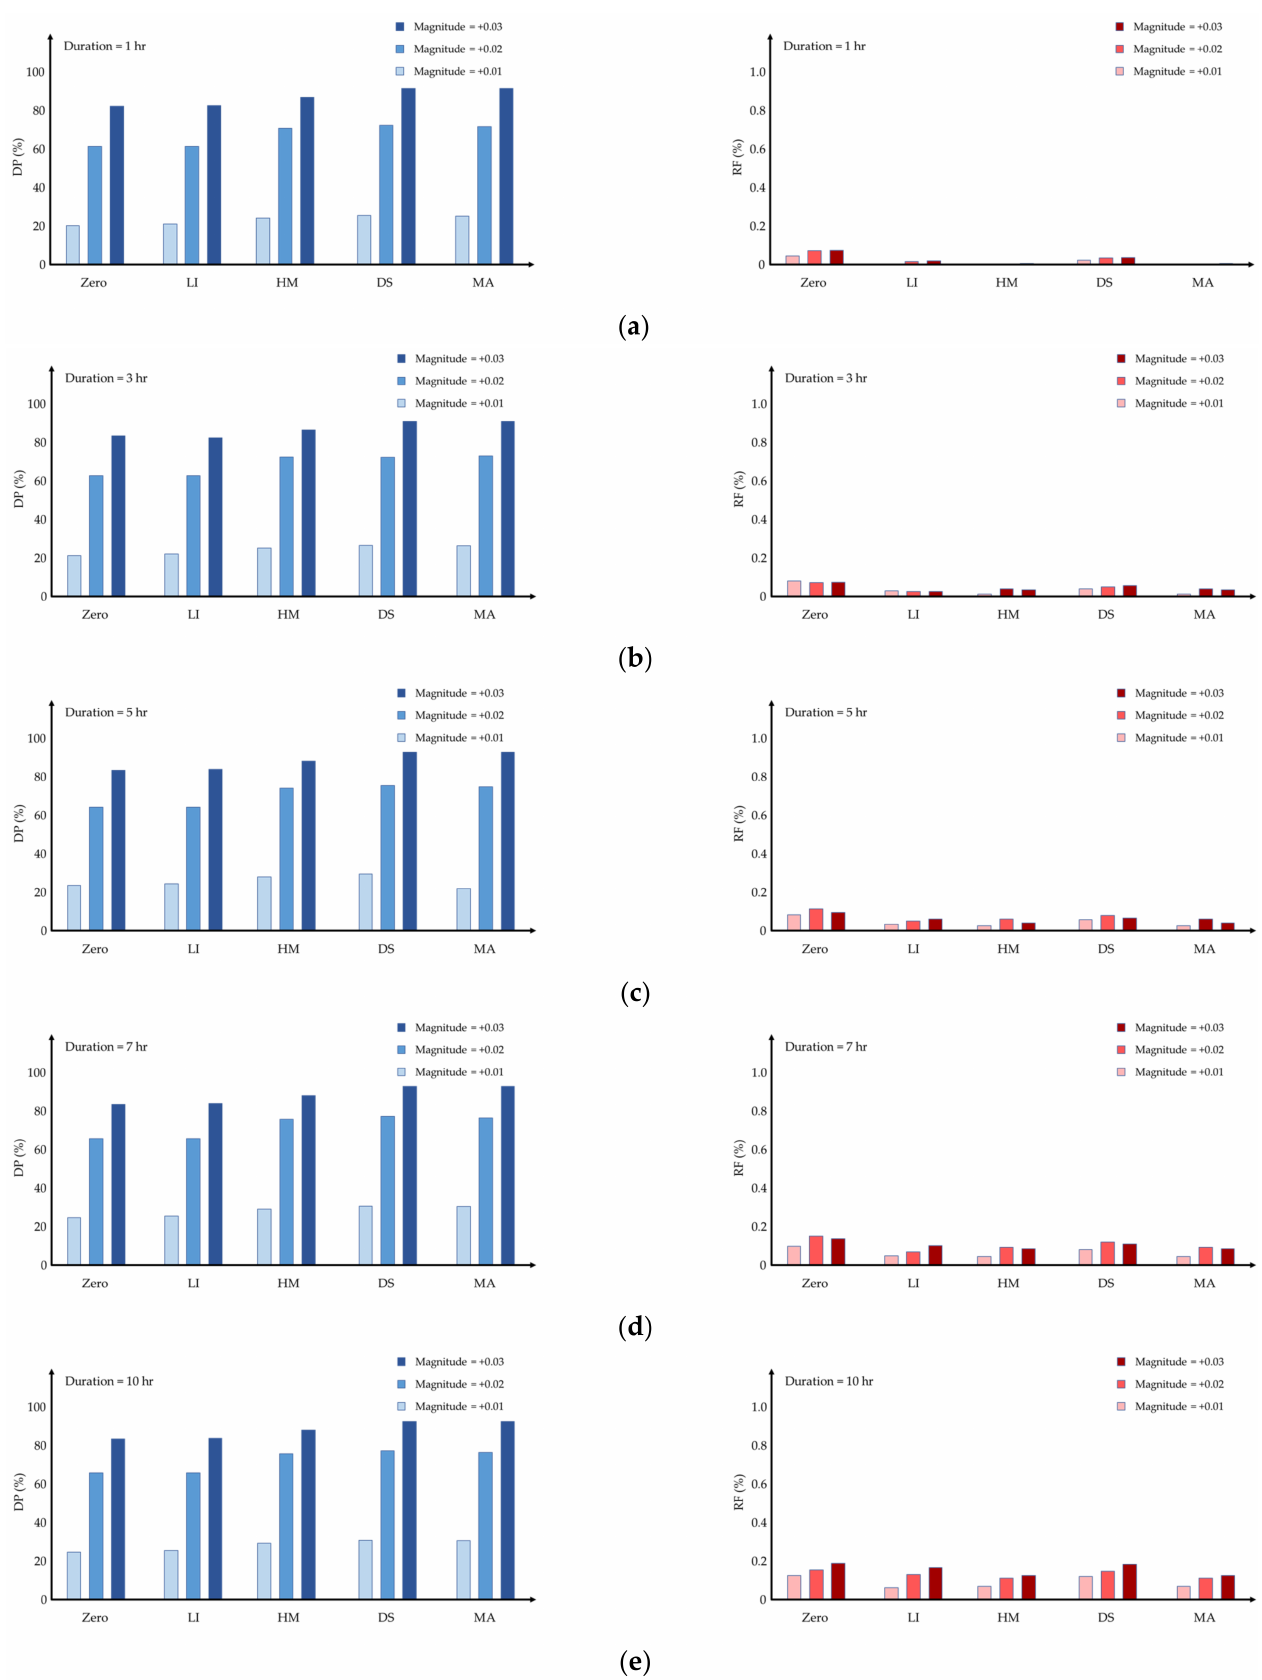
Figure 4. Detection performance using MA with threshold. ( a ) Duration = 1 h; ( b ) duration = 3 h; ( c ) duration = 5 h; ( d ) duration = 7 h; ( e ) duration = 10